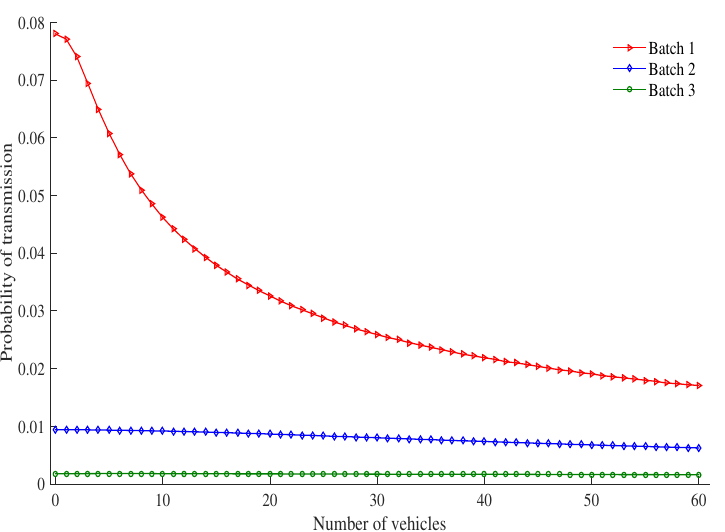
Figure 10. Probability of transmission vs. number of vehicles.